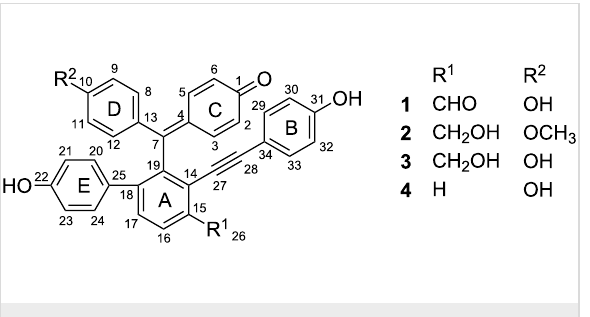
Figure 1: Structures of selaginellins from S. tamariscina .